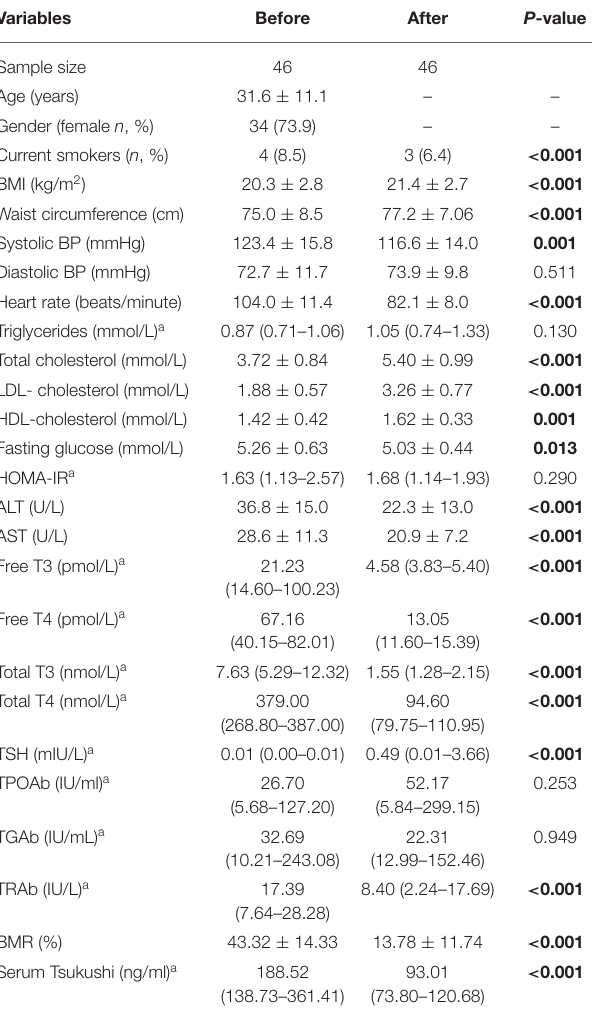
TABLE 4 | Odds ratios of hyperthyroidism according to serum Tsukushi levels. OR 95% CI P -value